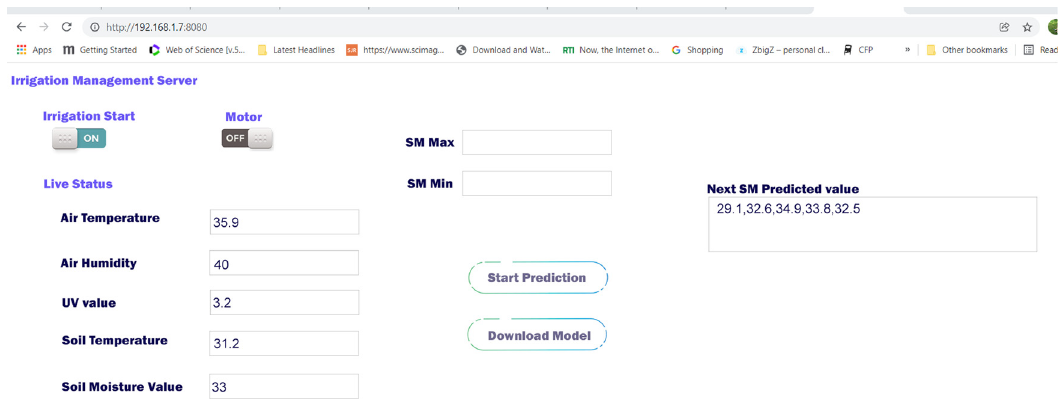
Figure 4: Web interface for the irrigation